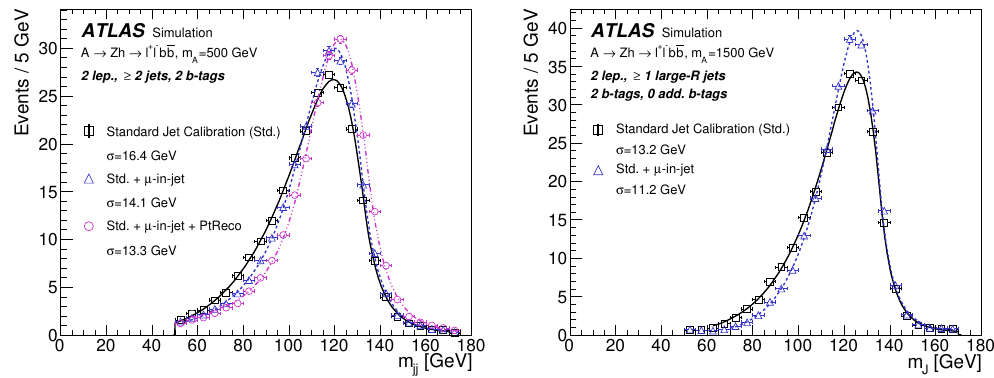
Figure 1. Reconstructed mass of the Higgs boson candidates for the (left) resolved and (right) merged event topologies in a sample of simulated signal events with m A = 500 GeV and m A = 1500 GeV respectively. The di(cid:11)erent distributions correspond to the di(cid:11)erent b -jet energy corrections applied in each case as described in the text. The distributions are (cid:12)t to the asymmet- ric function described in ref. [108] and the resolution parameter is shown in the